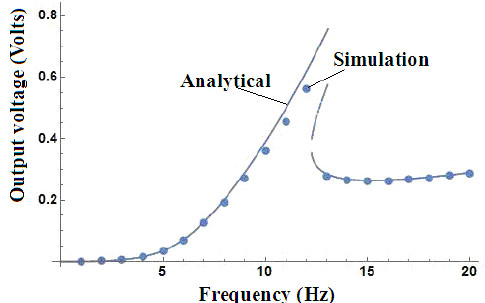
Figure 8. The calculated and simulated output voltages versus the excitation frequency using the analytical (Mathematica) (solid line) and simulation (Matlab Simulink) (solid round dots) methods in the nonlinear oscillator system.